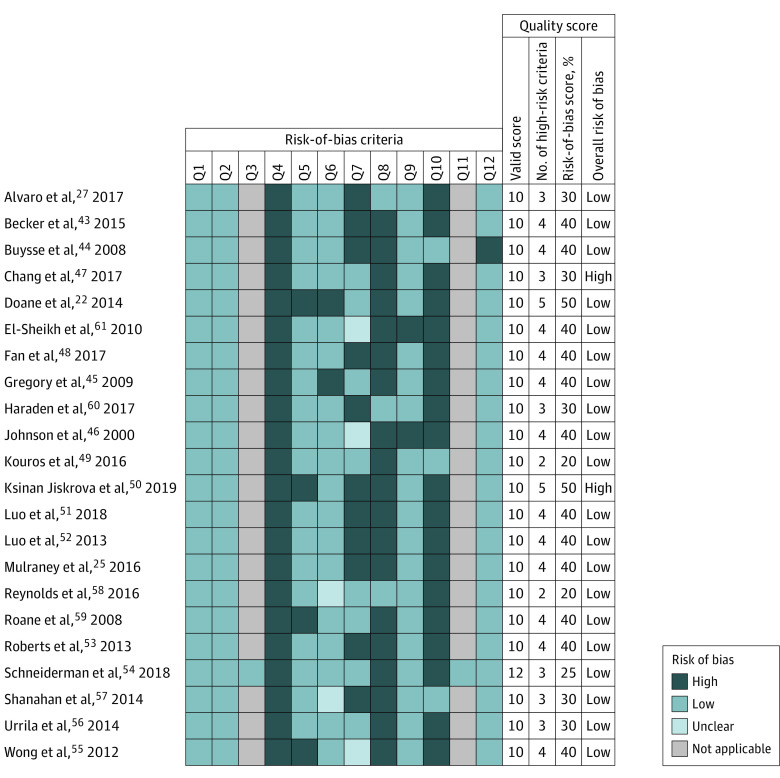
Risk-of-Bias Assessment of the Included Studies Based on the Research Triangle Institute Item Bank, by Heat MapThe overall risk-of-bias score was based on the ratio between the number of high and valid items (excluding not applicable items) times 100; scores of 50 or more identified high risk of bias.